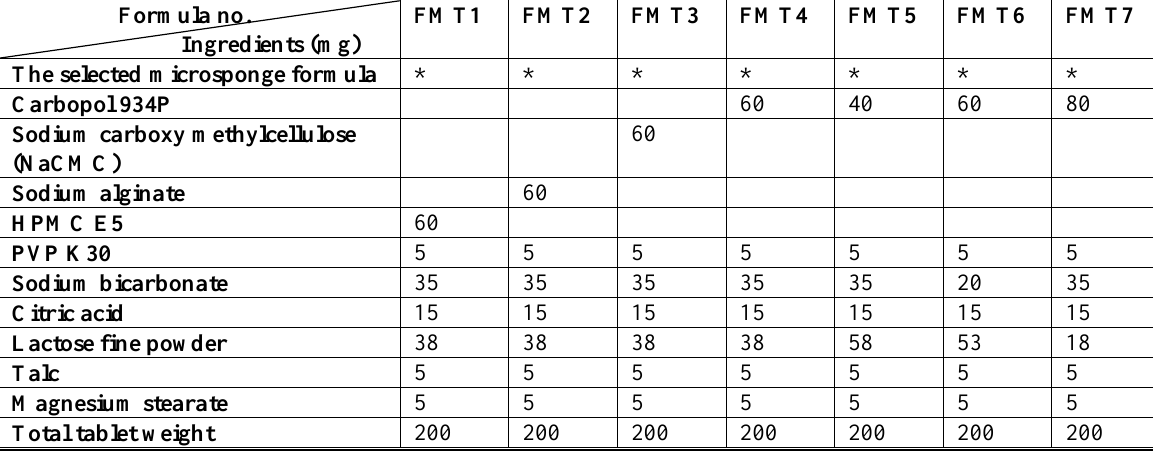
Table (2) Composition of BFN floating effervescent microsponge tablets Formula